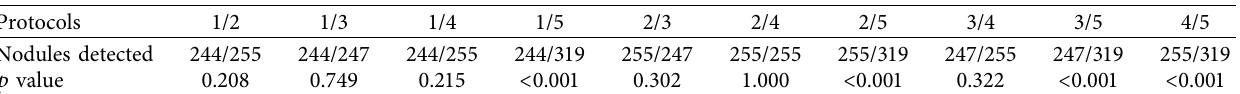
Figure 2: The number of nodules detected (gray columns, number 1) and missed (black columns, number 0) in each protocol (numbers 1 to 5, lower row) for every radiologist (numbers 1 to 4, upper row). Protocol 1: ULD, protocol 2: LD A, protocol 3: LD B, protocol 4: LD C, and protocol 5: CCT. Table 3: Comparison of the number of nodules detected by all radiologists for every pair of protocols using McNemar’s test.